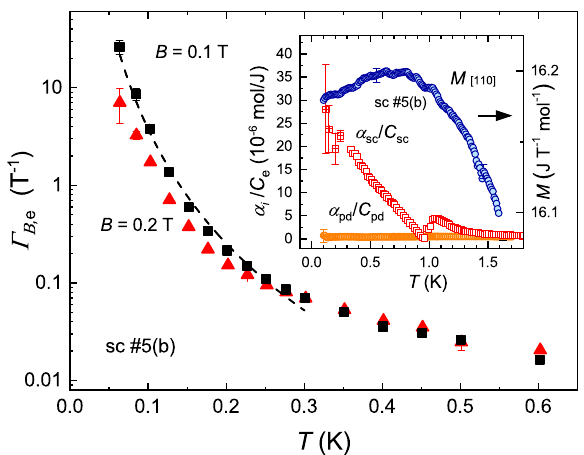
Fig. 5 Temperature dependence of the electronic magnetic Grüneisen parameter. Electronic magnetic Grüneisen parameter Γ B ,e as a function of temperature for PbCuTe 2 O 6 single crystal #5(b) in a semi-logarithmic representation. Raw data were taken by applying small fi eld ramps of Δ B = ±0.03 T on top of a dc fi eld of B = 0.1 T (black squares) and 0.2 T (red triangles) applied along [110], see “ Methods ” and Supplementary Note 2 as well as ref. 42 for details on the technique applied. A minimum dc fi eld of 0.1 T was used to avoid issues associated with remnant fi elds of the magnet. Broken line shows a fi t T - m with m = 3.9 to the data for T ≤ 0.25 K. Error bars result from averaging over fi eld-up and fi eld-down sweep. The inset (left ordinate) shows the ratio α sc / C sc = α [110] / C sc for single crystal #5 (open red squares) and α pd / C pd for the pressed-powder sample pd # Ι (open orange spheres) both measured at B = 0. Errors are calculated from the errors of α and C . The inset also shows results for the magnetization M ( T ) (right ordinate) per mole in a fi eld of B = 0.1 T along the [110] direction of sc #5(b) obtained by ac- susceptibility measurements. Representative error bar, denoting standard deviation due to statistical treatment of raw